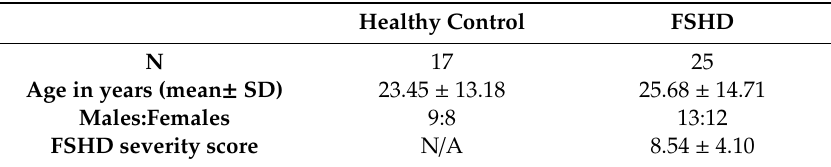
Table 3. Clinical characteristics of patients in proteomics discovery group.